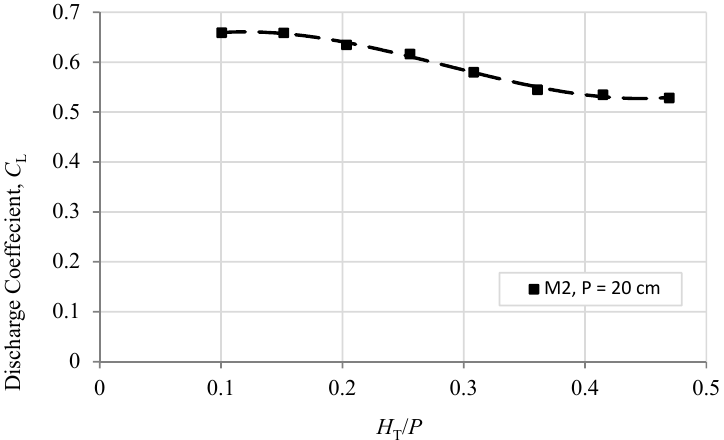
Figure 6. Variations in the discharge coefficient, C L , as a function of the H T /P ratio for the M2 model.